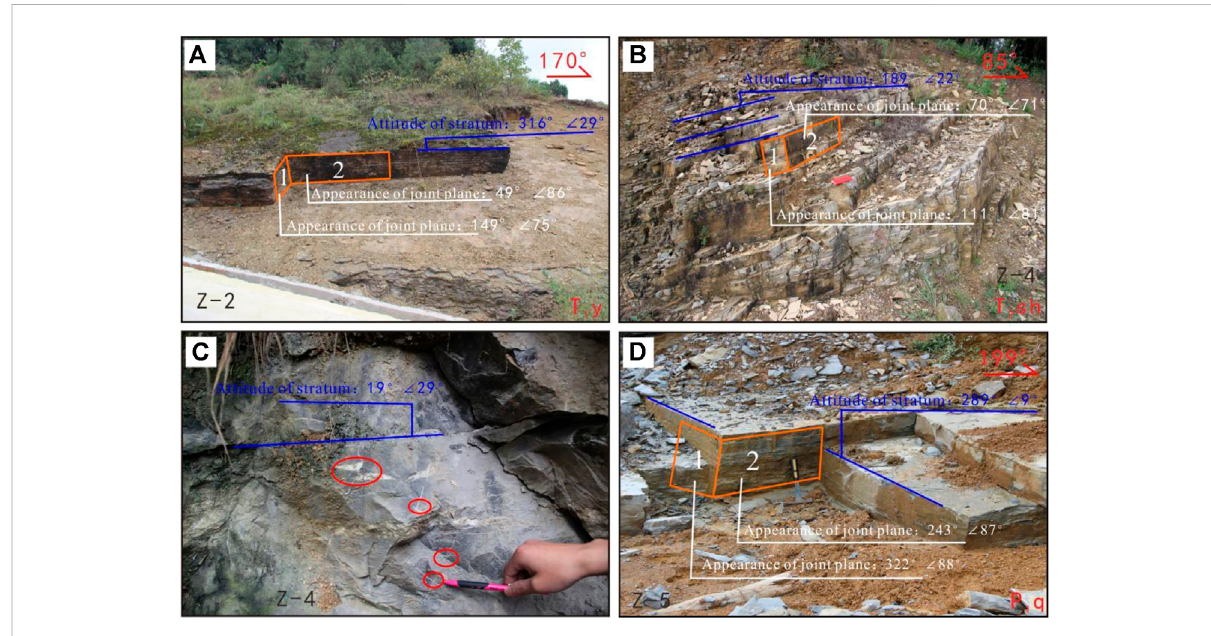
FIGURE 5 Photos of shale outcrops in Lintanchang area. (A) Observation point Z-2; (B) observation point Z-4; (C) observation point Z-4; (D) observation point